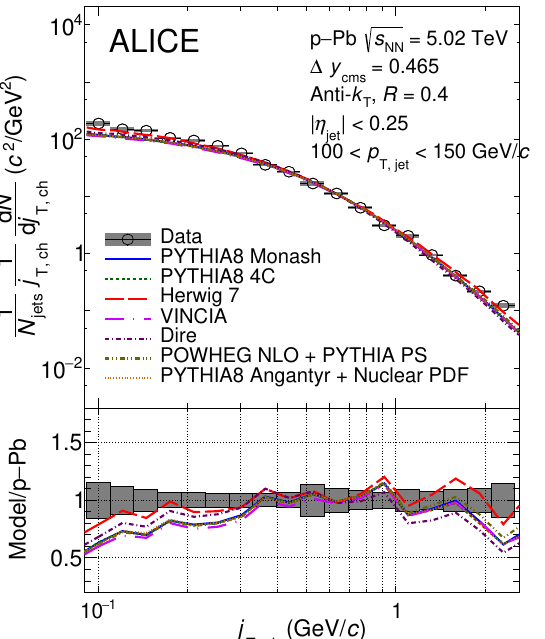
√ s NN = 5 . 02 TeV for 100 < p T , jet < 150 GeV/ c